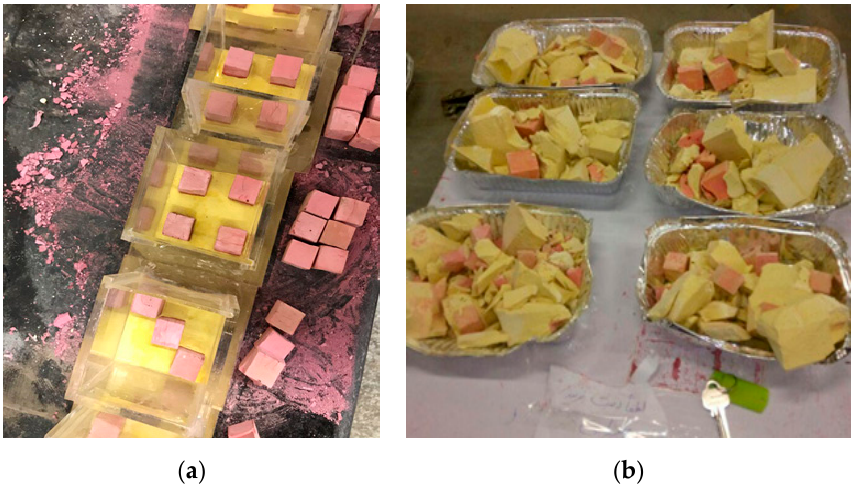
Figure 5. ( a ) Making artificial two-phase ores; ( b ) crushed two-phase artificial ores.